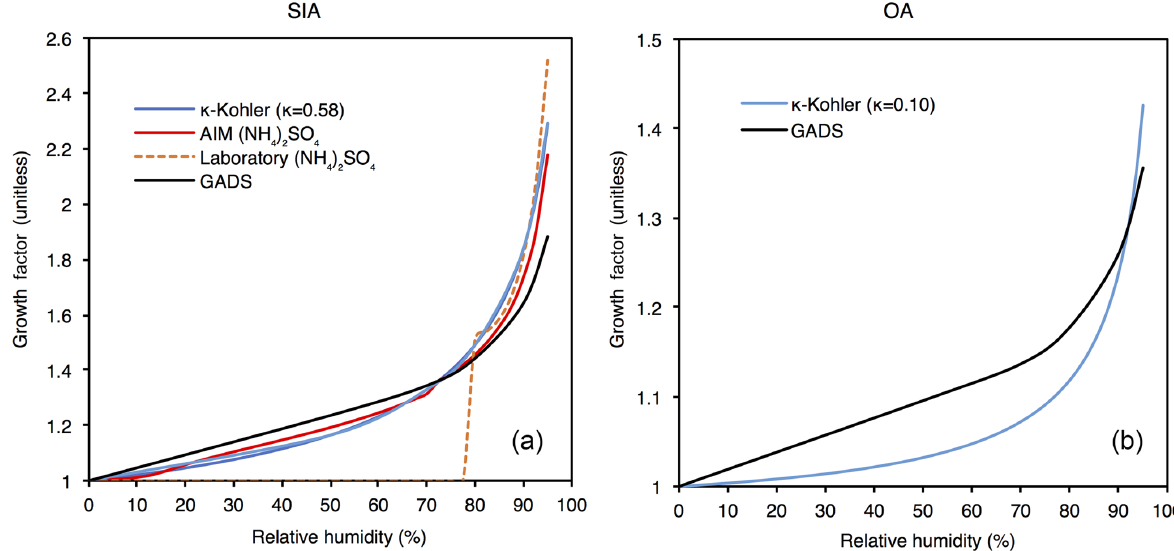
Figure 9. Hygroscopic growth factor curves for secondary inorganic aerosols (SIA, a ) and organic aerosols (OA, b ). GADS (Global Aerosol Data Set) hygroscopic growth from empirical data and κ -Kohler hygroscopic growth are shown for both SIA and OA. For ammonium sulfate, AIM (Aerosol Inorganic Model) hygroscopic growth at T = 298K (Wexler and Clegg, 2002) and laboratory hygroscopic growth with a deliquesence point of RH = 80% (Wise et al., 2003) are also